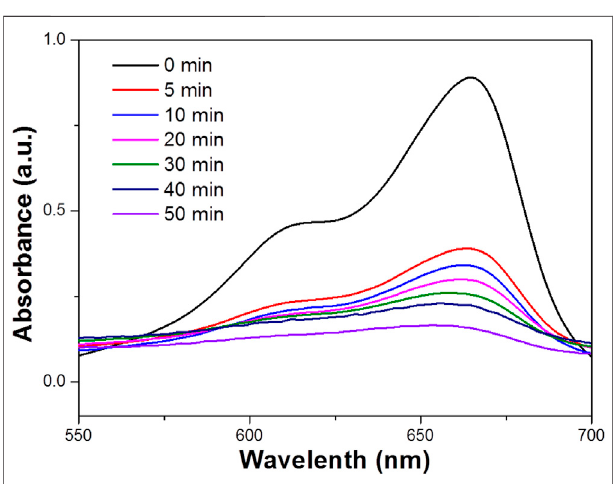
FIGURE 4 | UV – vis absorbance spectrum for the aqueous dispersion of the